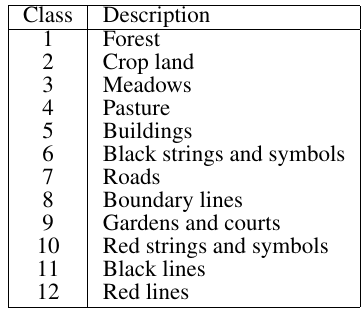
Table 2. LULC classes used for OBIA classification. Simple Majority Vote (SMV), Simple Weighted Vote (SWV), Best Worst Weighted Vote (BWWV) and Quadratic Best Worst